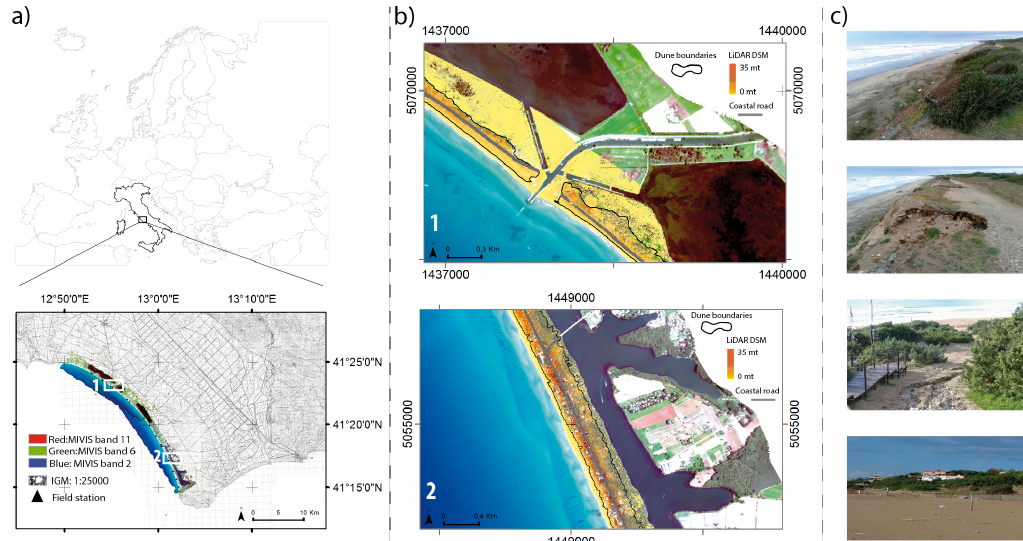
Figure 1. ( a ) Study area location with basic cartography and the hyperspectral Multispectral Infrared Visible Imaging Spectrometer (MIVIS) data coverage; ( b ) miniature 1 and 2 are the two zooms of the study area highlighted in (a), with the light detection and ranging (LiDAR) digital surface model (DSM) on MIVIS true color imagery; ( c ) pictures of the area taken in May 2009.